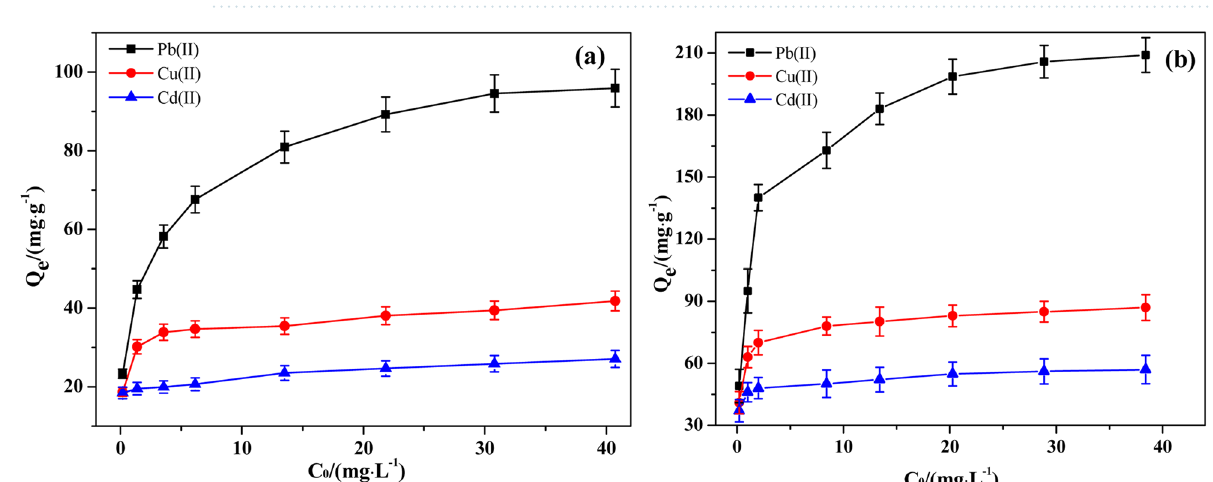
Figure 5. Effect of pH on the adsorption performance of 6O-MWCNTs ( a ) and 6O-MWCNTs@Fe 3 O 4 ( b ).